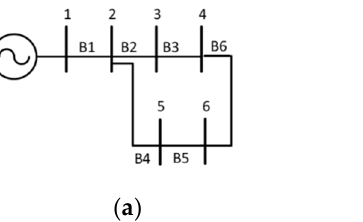
BIBC matrix is updated with using (7). Branches those formed a loop are affected with added line. Opened branch, B4 , row of BIBC matrix become zero as in Figure 3b. Negative value on the B5 row indicates power flow direction is changed on 5th branch. Closed line B6 is replaced with opened one B4 on BIBC matrix and branch currents of reconfigured system as in Figure 3a are given in (8).